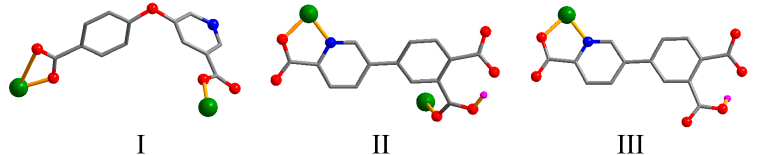
Scheme 2. Coordination modes of µ -cpna 2 − (mode I) and µ -Hdppa 2 − /Hdppa 2 − (modes II, III) blocks in 1 and 2 .